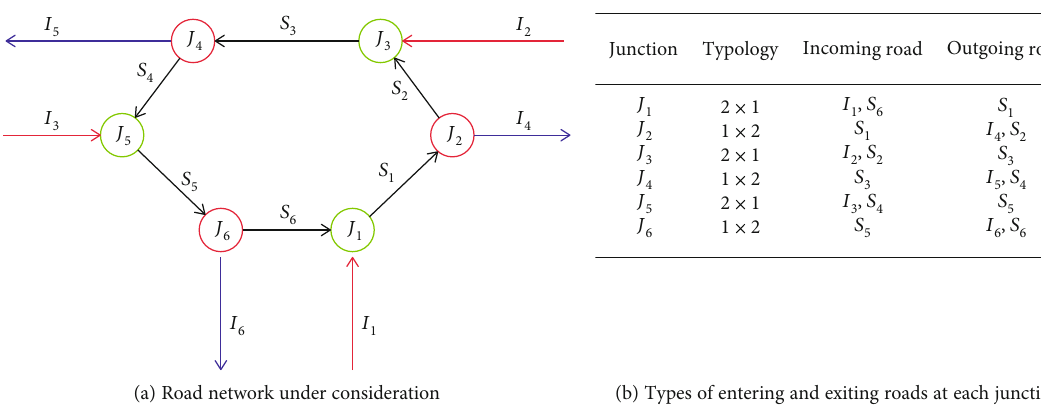
Figure 2: Road networks of a roundabout and its corresponding